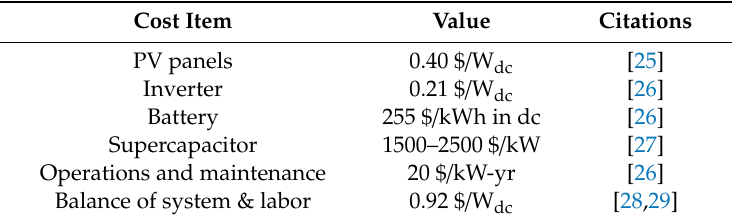
Table 1. Summary of cost items relevant to a PV